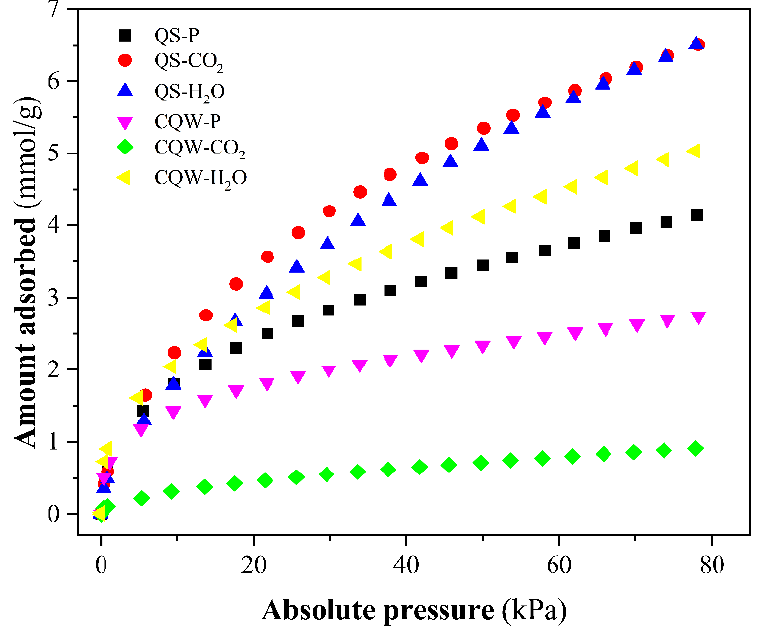
◦ C of the prepared